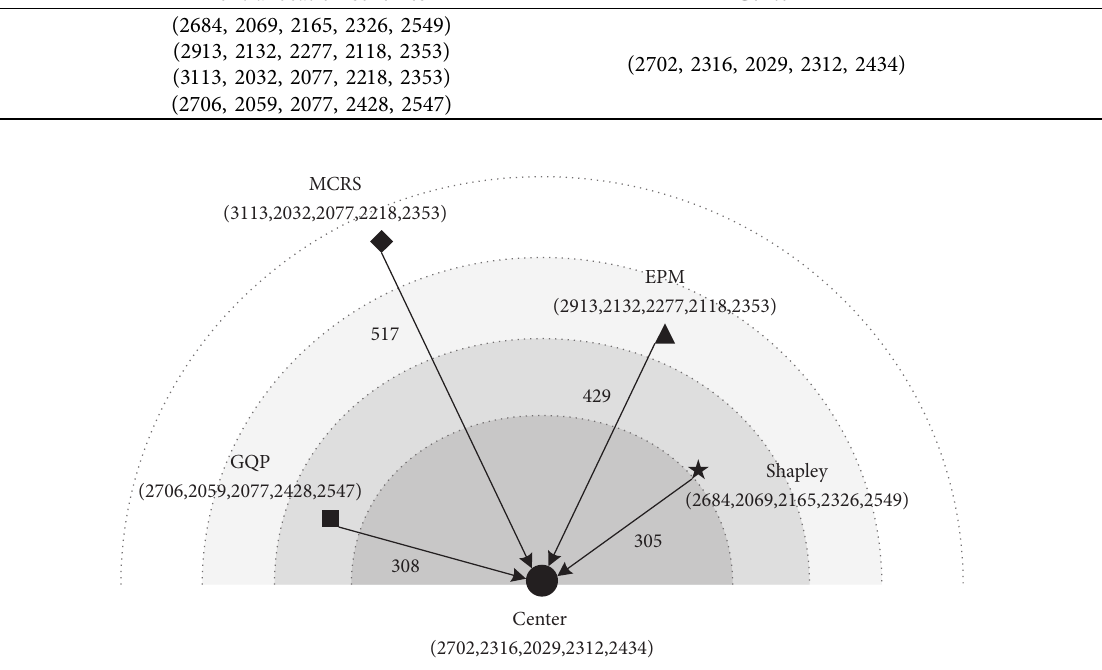
Figure 12: Comparison of distances between different methods and center